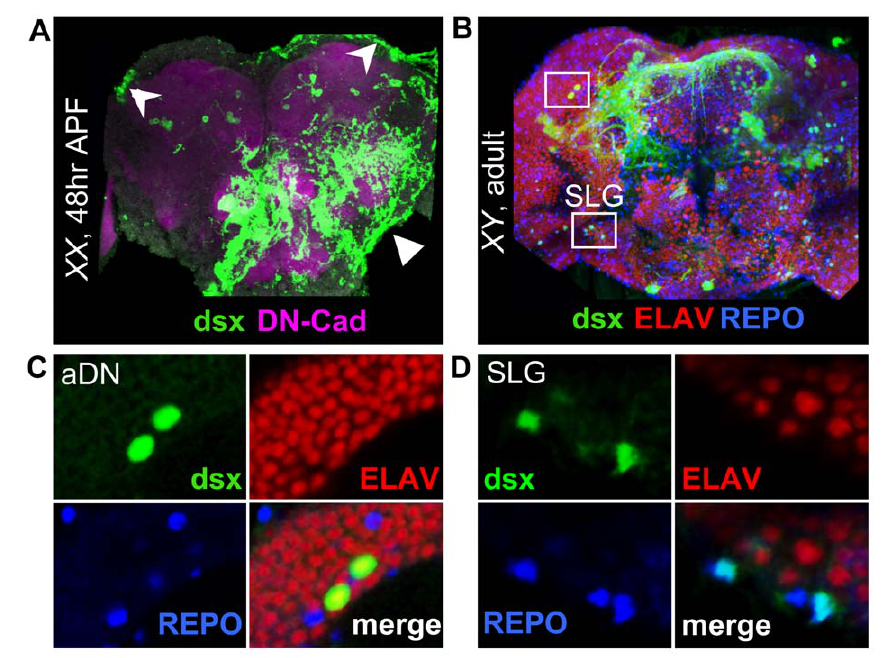
Figure 8. dsx GAL4 is expressed in a subset of glial cells in the CNS. (A) dsx GAL4 is expressed in cells with glial morphology (arrows) that are associated with the cortical surface of the brain in a female at 48 h APF, as shown using UAS-mCD8::GFP membrane-bound GFP reporter. Shown here is a projection of the anterior brain, revealing cells across the medial optic cleft and suboesophageal ganglion (arrowhead). Expression is also seen in some samples at the cortical surface of the lateral horn (barbed arrowheads). Neuropile is counterstained with DN-Cadherin (DN-Cad). (B) dsx GAL4 expression in the anterior brain of a 0 d adult male using the UAS-Stinger nuclear GFP reporter. Costaining for the neuronal marker ELAV (red) and the glial marker REPO (blue) reveals overlap with dsx GAL4 in a subset of neurons and glia. In the region of the anterior Dorsal Neurons (aDN, detailed in panel C), we observe overlap with ELAV but not REPO. However, in the anteroventral optic cleft, we observe overlap with REPO but not ELAV, confirming the glial cell type of the Suboesophageal Lateral Glia (SLG; detailed in panel D). (C) The aDNs (green) are positive for ELAV (red) but not REPO (blue). (D) The SLG in the anteroventral optic cleft are positive for REPO but not ELAV.